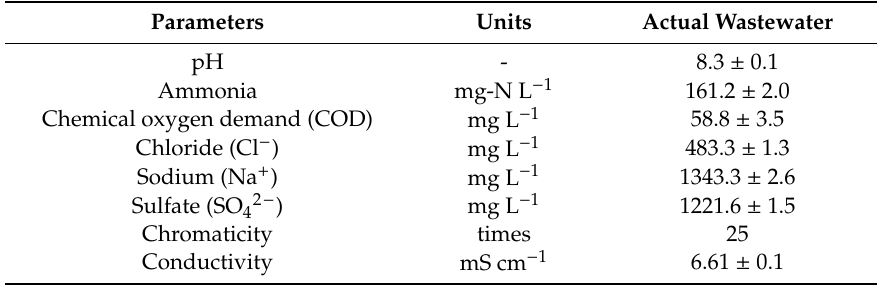
Table 1. The physicochemical characteristics of actual dyeing wastewater used in this